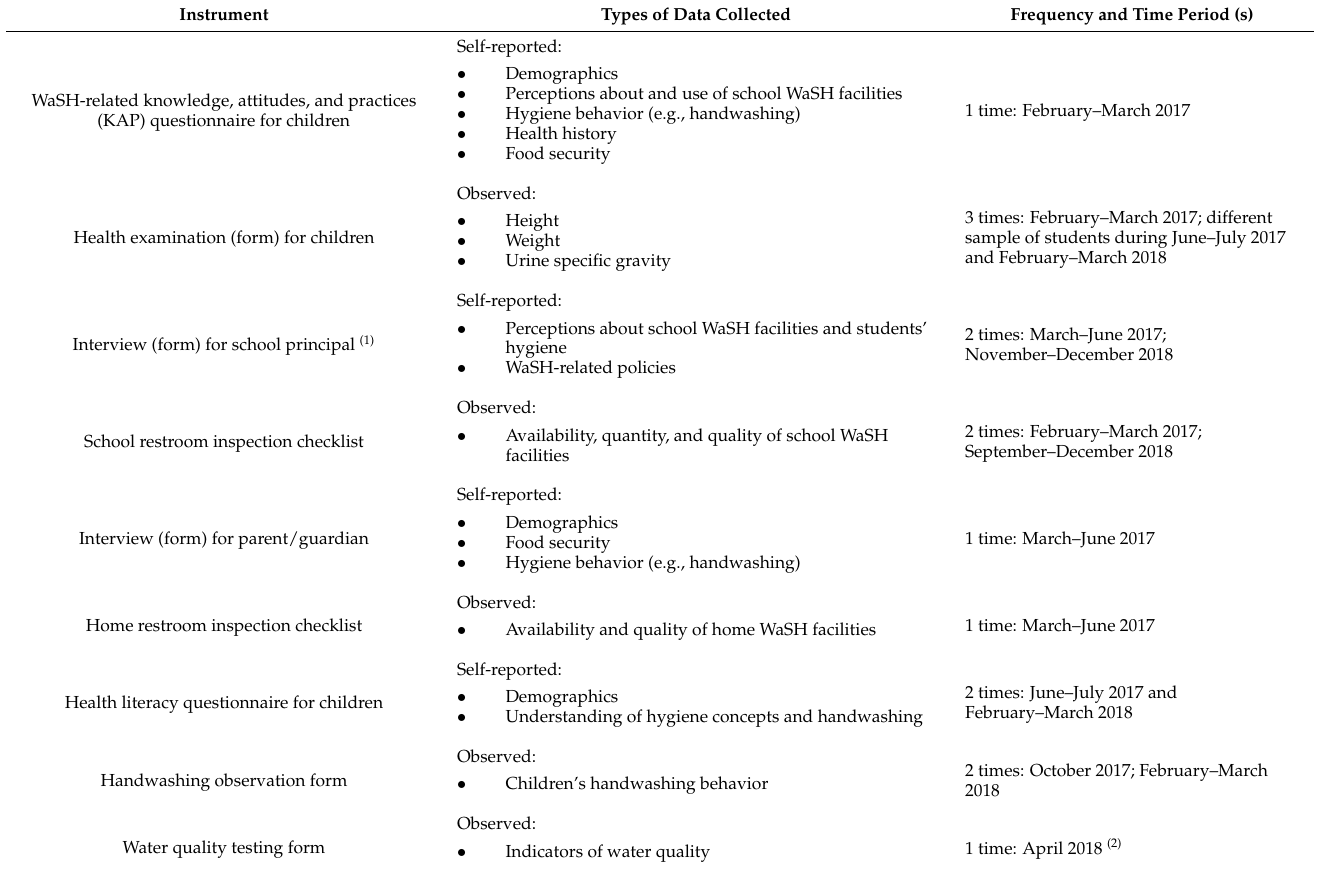
Table 2. Data collection during the WaSH in Manila Schools